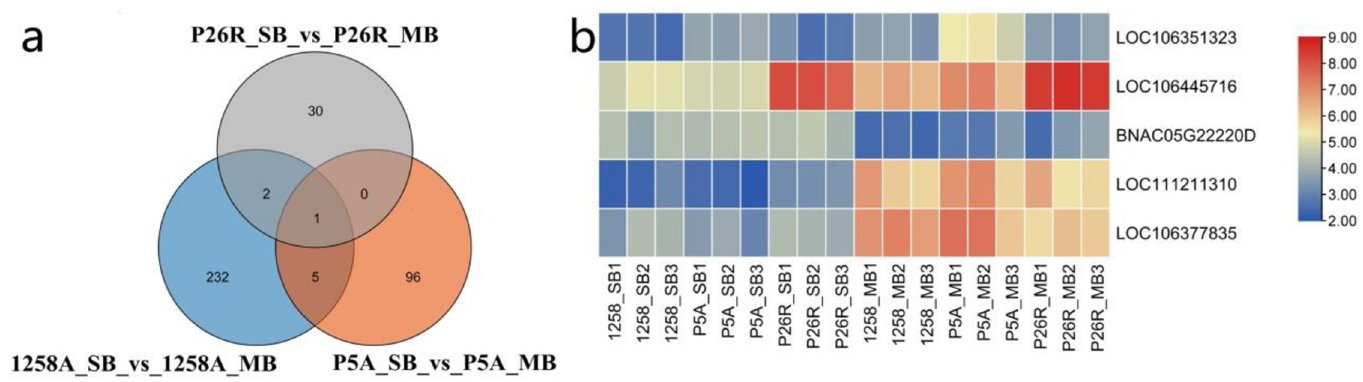
Fig 9. Venn diagram of the Cis- target genes of lncRNAs and the levels of expression of its common target genes in rapeseed buds.